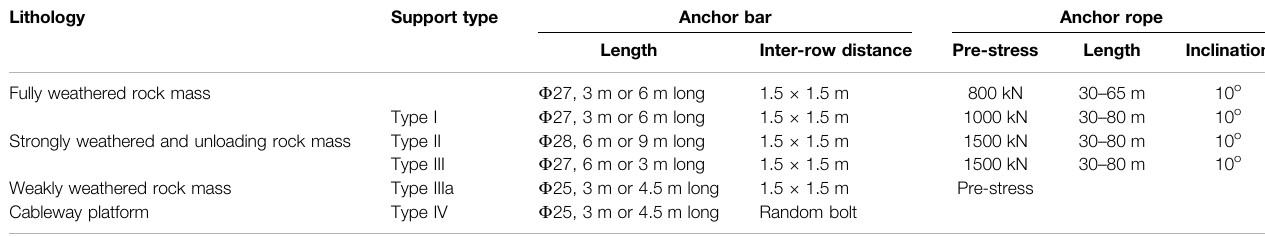
TABLE 3 | Main supporting measures for the left bank slope.